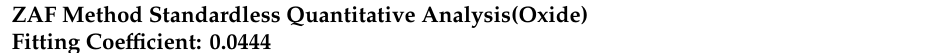
Table 6. Oxide of Coco-husk ( Cococs nucifera ).